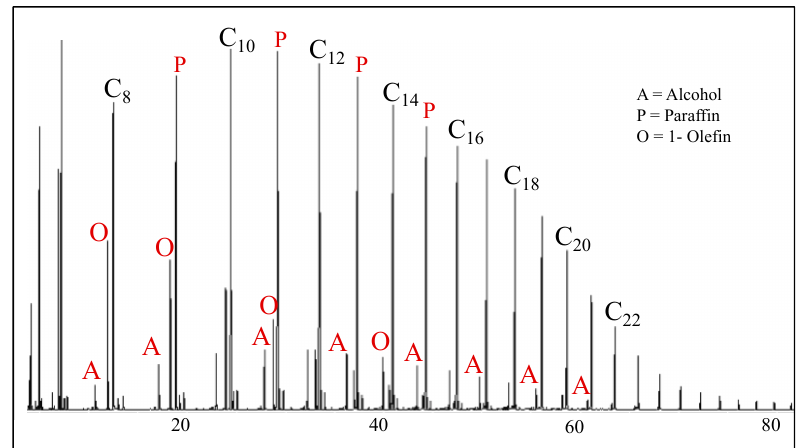
Figure 17. A chromatographic picture of a silica supported cobalt catalyst. The x-axis is retention time in minutes. Reaction Conditions: 220 °C, 27.6 bar, WHSV = 3, and H 2 /CO = 2.